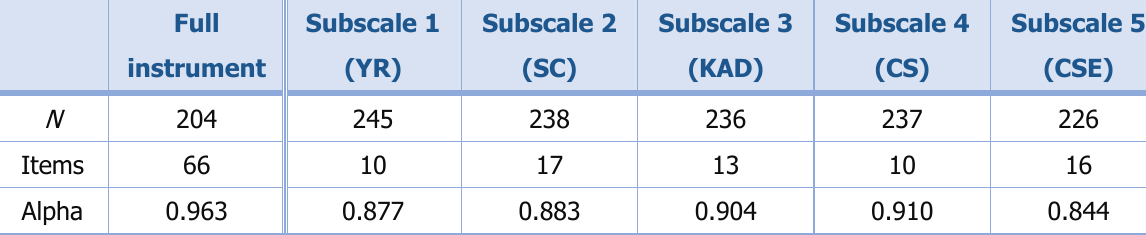
Table 4. Cronbach’s Alpha, 66 -Item Instrument — Round